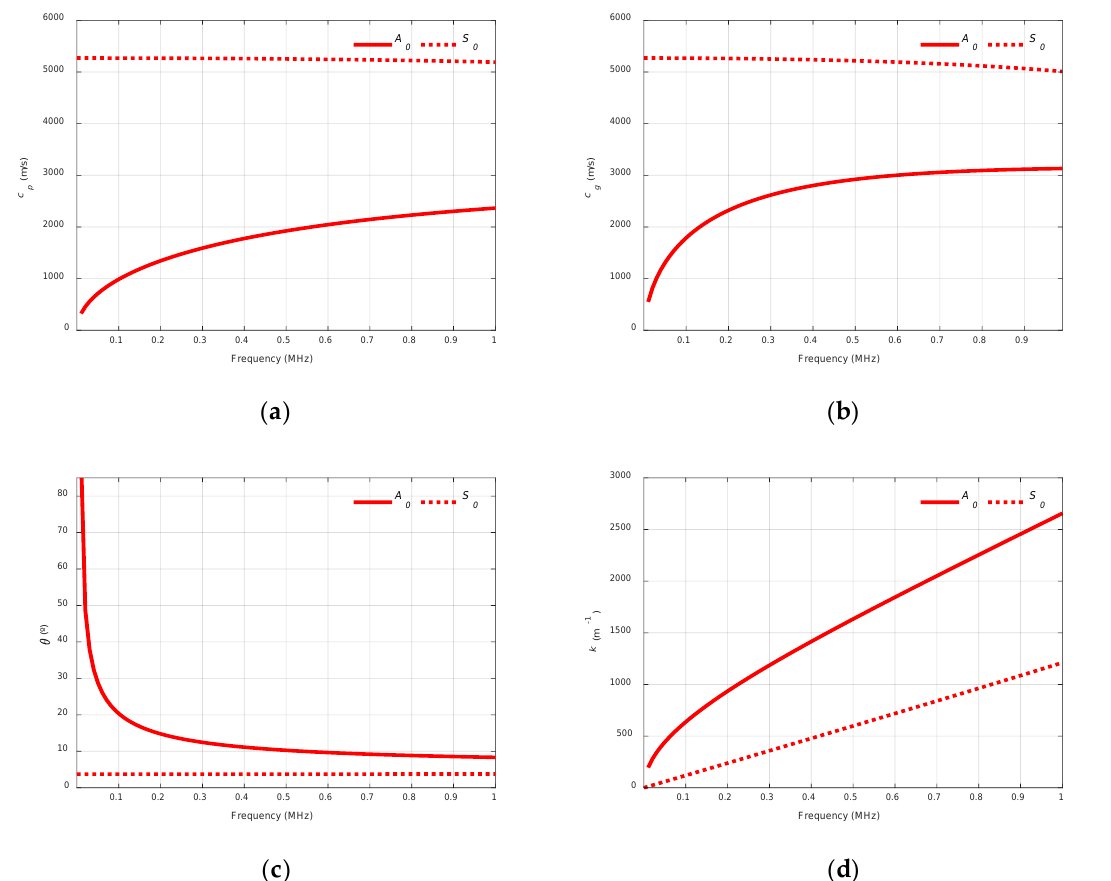
Figure 3. Dispersion curves for a stainless steel plate ( c L = 5851 m / s, c T = 3056 m / s, 2 h = 1.1 mm): ( a ) Phase velocity, c p ; ( b ) Group velocity, c g ; ( c ) Incident angle, θ , for air (343 m / s); ( d ) Wavenumber, k